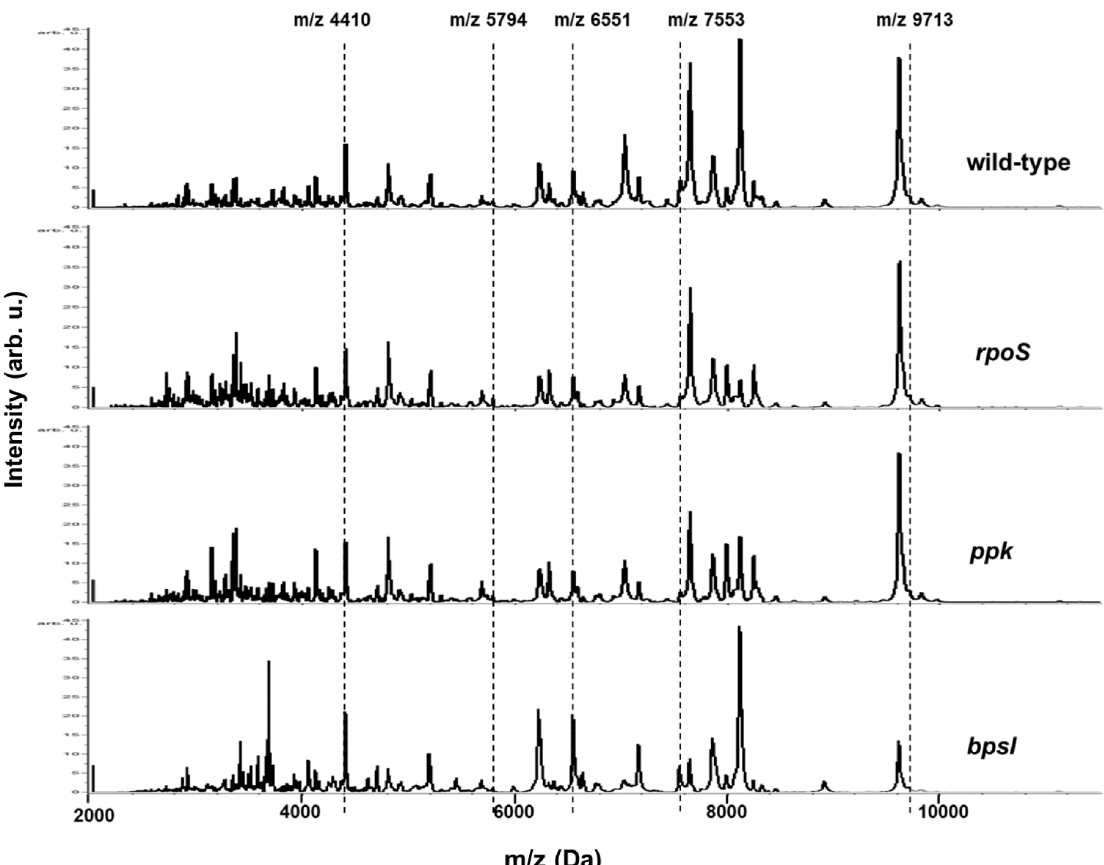
Fig 1. Taxon-specific biomarkers in B . pseudomallei average mass spectra. Five effective species-specific biomarkers, including m/z 4410, 5794, 6551, 7553, and 9713, were detected in all of the average mass spectra examined (the vertical dashed lines).